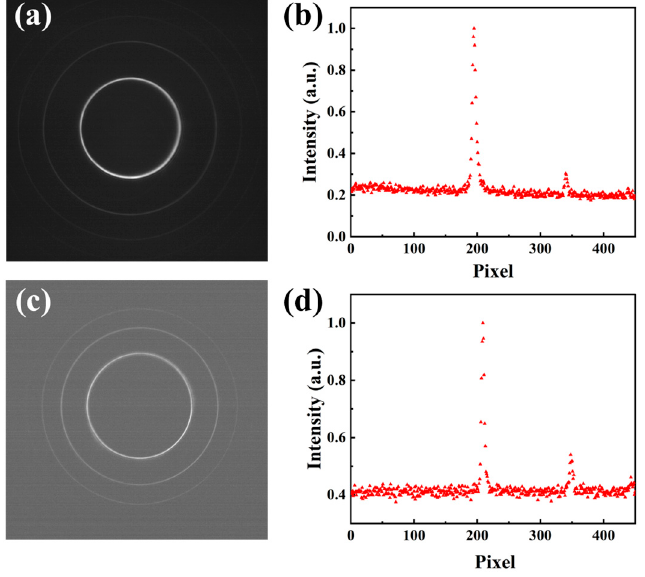
Figure 2. ( a ) Recorded Interference circle (R = 95%), ( b ) scatter plot of normalized pixel intensity (R = 95%), ( c ) recorded Interference circle (R = 99.5%), and ( d ) scatter plot of normalized pixel intensity (R = 99.5%).